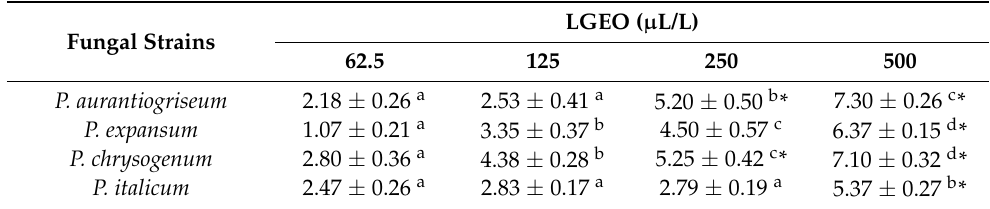
Table 3. Antifungal in vitro activity of lemongrass essential oil expressed by measuring the inhibition zone diameters